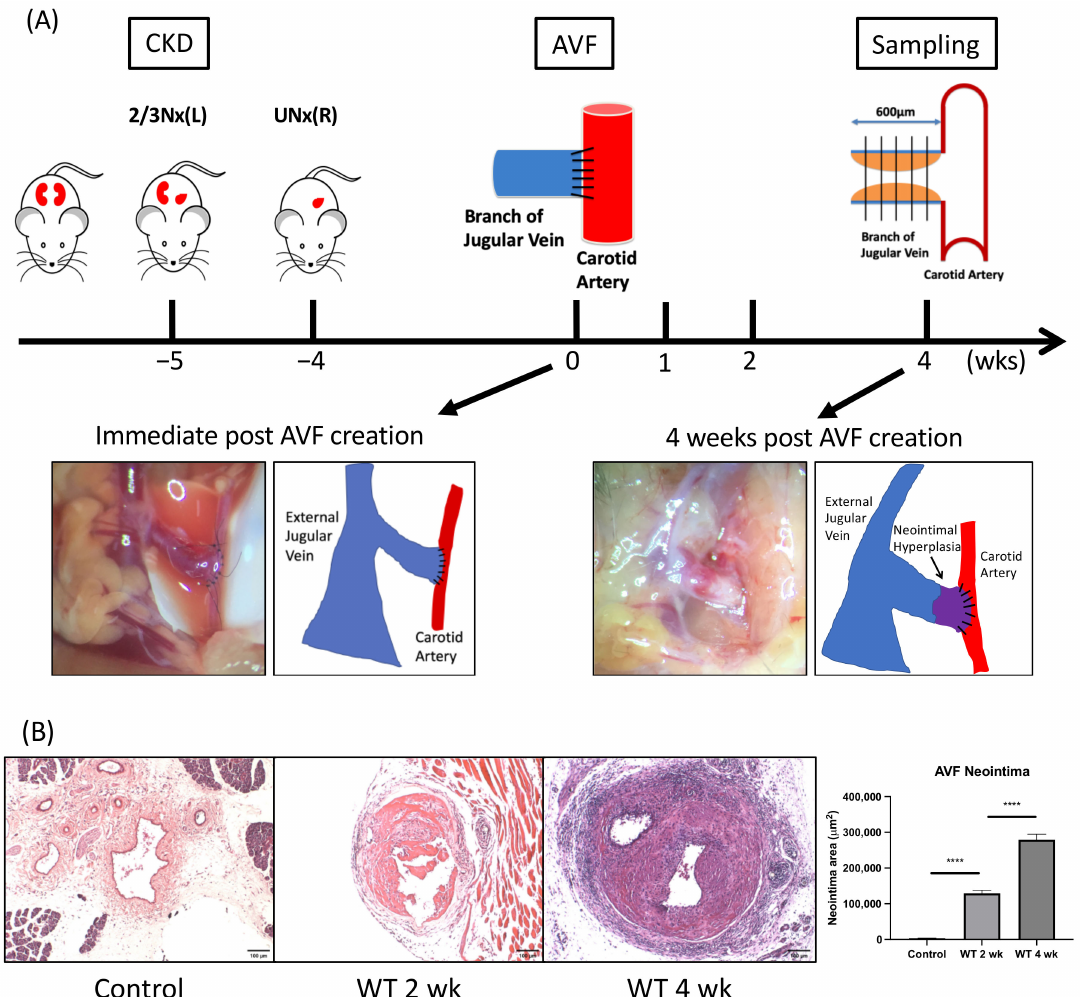
Figure 1. Neointima formation in the venous outflow tract of arteriovenous fistula (AVF). ( A ) Wild-type (WT) mice underwent 5/6 nephrectomy for chronic kidney disease (CKD) induction, followed by AVF creation four weeks later. Grossly, neointima formation was observed at proximal AVF venous segment. ( B ) Histologically, the initial 600 µ m venous outflow tract was divided into five 100 µ m thick segments as illustrated in ( A ), scale bar = 100 µ m. After elastin staining, neointima at each segment was examined, which was found to enlarge gradually after AVF creation. **** p < 0.0001. Data presented as mean ± SEM and analyzed using one-way analysis of variance (ANOVA) followed by Bonferroni post hoc analysis; n = 6–7 in each group. AVF, arteriovenous fistula; CKD, chronic kidney disease; 2/3 Nx, 2/3 nephrectomy; UNx, uninephrectomy; WT,